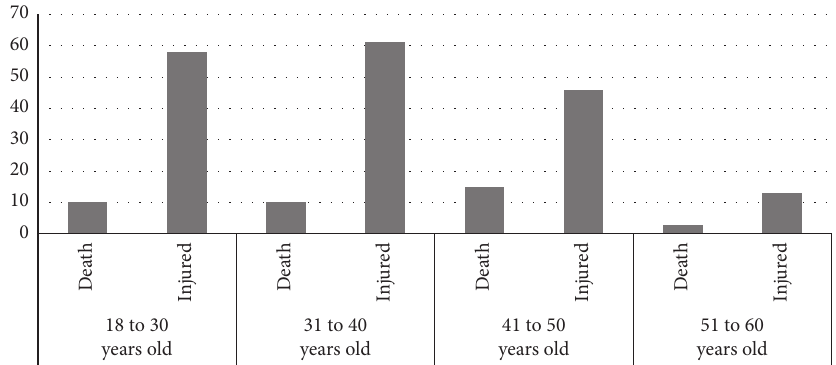
Figure 2: Casualties caused by drivers of different ages.